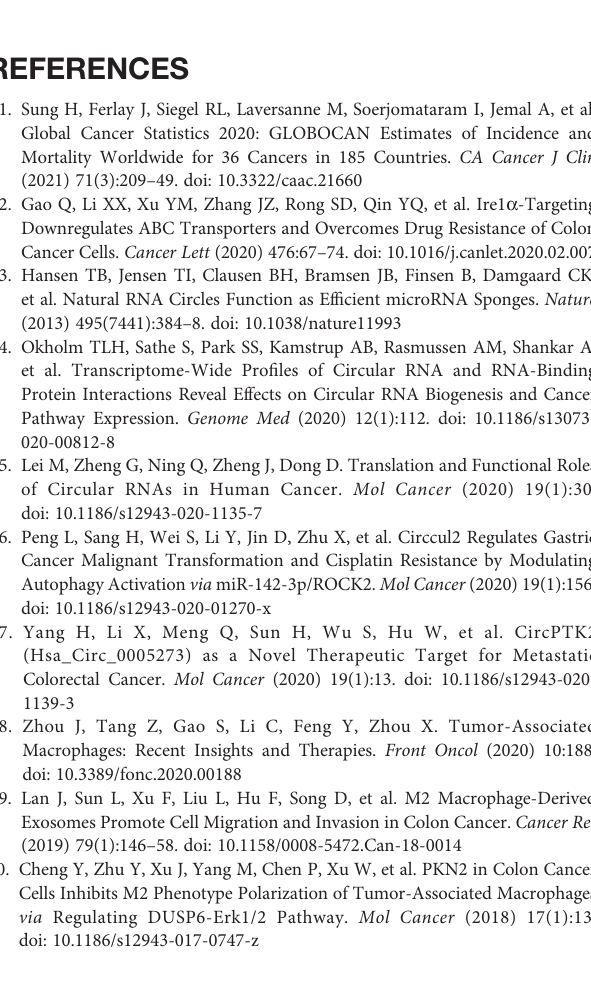
Supplementary Figure S4 | Correlation between ZC3H10 expression and markers of immune cells as analysed through GEPIA2. (A) for B cell, (B) for CD4+ T cell, (C) for CD8+ T cell, (D) for dendritic cell, (E) for effector regulatory T (Treg) cell, (F) for eosinophils, (G) for exhausted T cell, (H) for mast cell, (I) for monocyte, (J) for neutrophils, (K) for natural killer (NK) cell, (L) for resting regulatory T (Treg) cell, (M) for T follicular helper (Tfh) cell, (N) for T helper type 1 (Th1) cell, (O) for Th2 cell, and